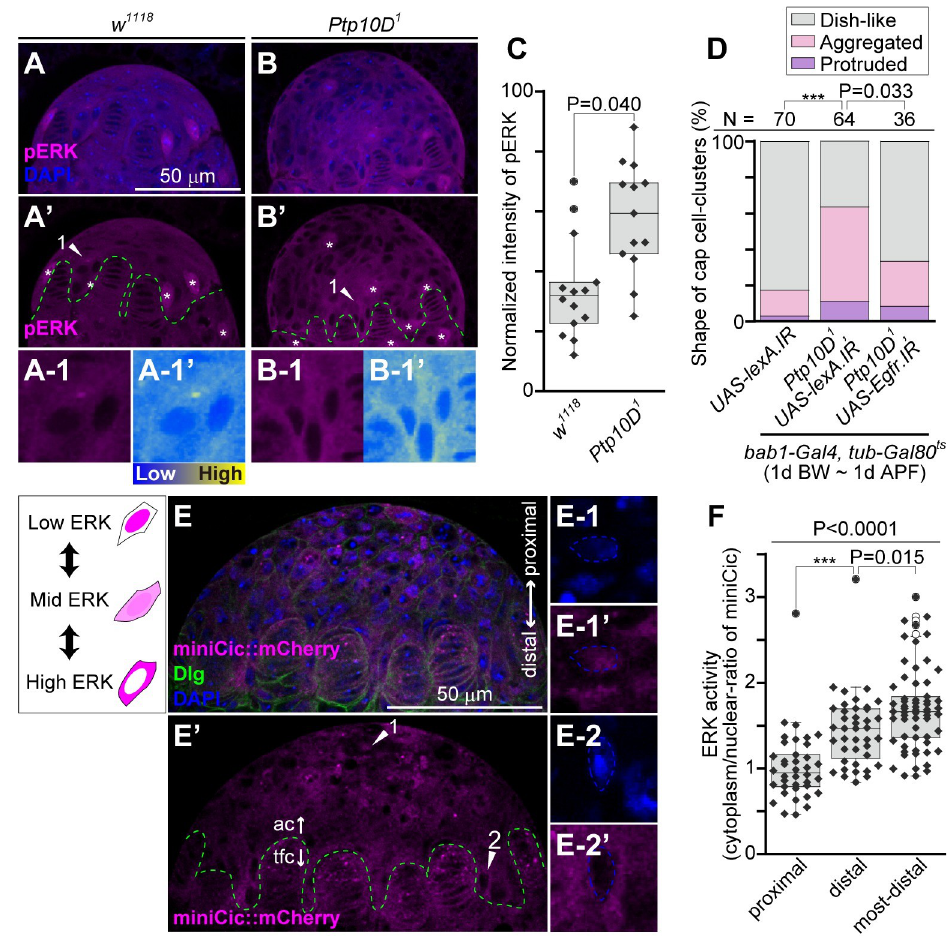
Fig 3. Loss of Ptp10D causes abnormal shape of cap cell-cluster via elevated Egfr signaling. (A and B) Female gonads of late wandering larvae in w 1118 and Ptp10D 1 homozygotes were labelled with anti-pERK antibody (magenta) and DAPI (blue). (A’ and B’) Magenta channels of (A and B). Asterisks in (A’ and B’) indicate non-specific staining of anti-pERK in mitotic cells. Green dashed lines in (A’ and B’) indicate the boundaries between apical cells and terminal filament cells. Apical cells indicated by arrowheads 1 in (A’ and B) are shown in (A-1 and B-1). Heatmap images of (A- 1 and B-1) are shown in (A-1’ and B-1’). (C) Boxplot overlaid with beeswarm plot represents the normalized intensity of pERK staining. Data values from w 1118 and Ptp10D 1 are plotted. P-value for Mann-Whitney U test are shown. (D) 100%-stacked bar graph represents % of germaria with normal (gray), aggregated (pink), and protruded (purple) cap cell-clusters in indicated genotypes. lexA . IR was used as a control. Numbers (N) of samples observed and P-values ( *** P < 0.0001, 0.01 < “actual P-value” < 0.05) for the pairwise comparison using Fisher’s exact test with Bonferroni correction are shown. P-values for the pairwise comparison to the dish-like/aggregated pair are shown. Other pair (dish-like/protruded and aggregated/protruded) did not showed significant differences (P < 0.05) for this pairwise comparison. (E) Female gonads of late wandering larvae having one copy of tub-miniCic :: mCherry transgene were labeled with mCherry fluorescence (magenta) and anti-mCherry antibody (magenta), anti-Dlg antibody (green) and DAPI (blue). (E’) Magenta channel of (E). Green dashed line in (E’) indicates the boundary between apical cells (ac) and terminal filament cells (tfc). A proximal cell and a most-distal cell exhibiting typical ERK activity indicated by arrowheads 1 and 2 in (E’) are shown in (E-1 and E-1’) and (E-2, E-2’), respectively. Blue channels (E-1 and E-2) and magenta channels (E-2 and E-2’) are shown. Blue dashed lines in (E-1’ and E-2’) indicate outlines of nuclei. (F) Boxplot overlaid with beeswarm plot represents the ratio of mimiCic intensity in cytoplasm to that in nucleus in each apical cell. Data values from apical cells located in proximal region, distal region, and most-distal region are plotted. P-value for Kruskal-Wallis rank sum test to three distributions is shown (line). P-value ( *** P < 0.0001, 0.01 < “actual P-value” < 0.05) for Mann-Whitney U test with Bonferroni correction (post-hoc test) are